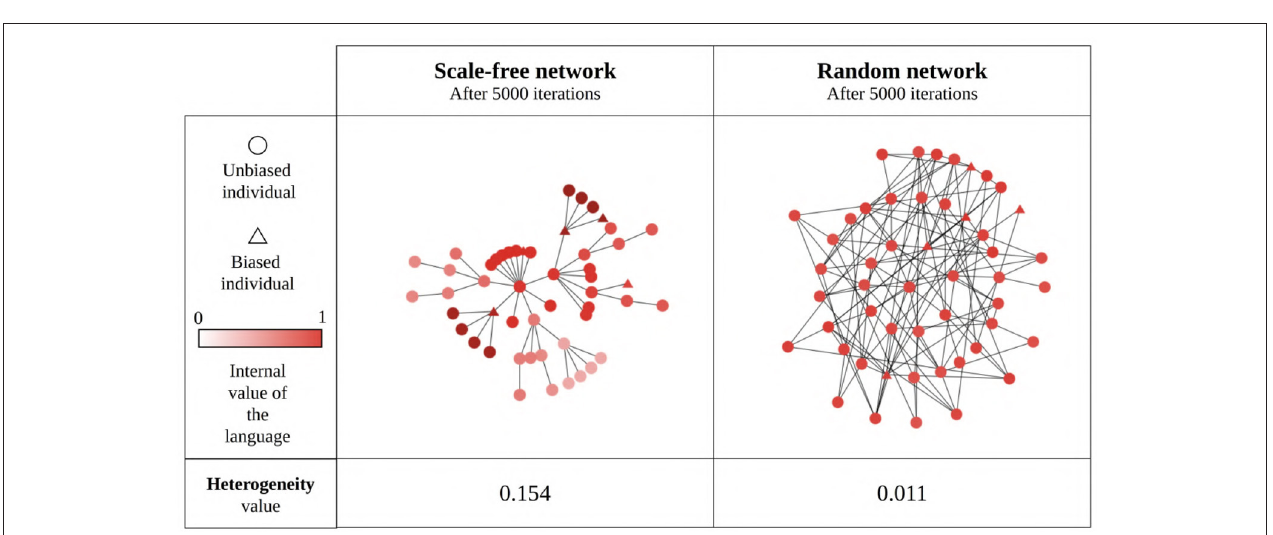
FIGURE 11 | An example of linguistic community emergence in scale-free (left) and random (right) networks with 50 SAM agents, 10% of which are strongly biased (triangles) while the remaining 90% are unbiased (circles). Agent colors represent their language value; agents were exposed to an initial language.